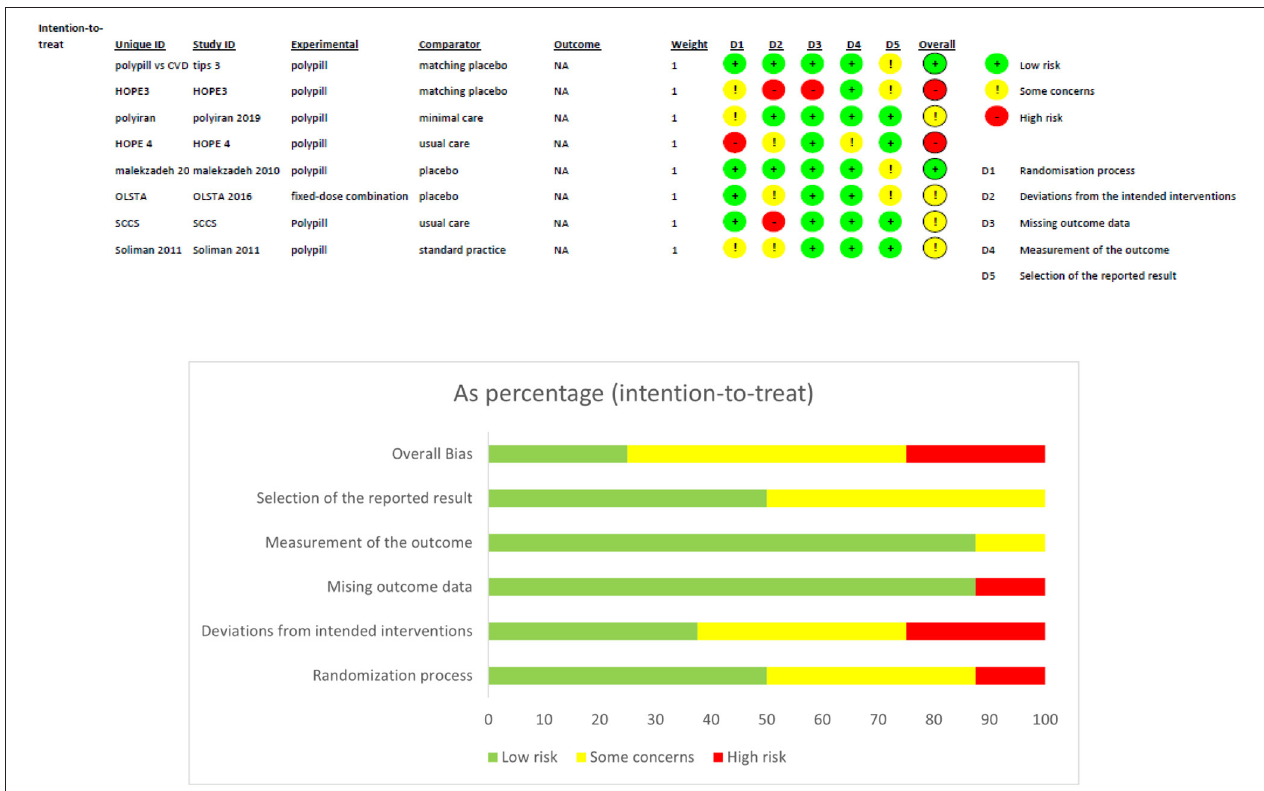
FIGURE 2 | Risk of bias assessment and